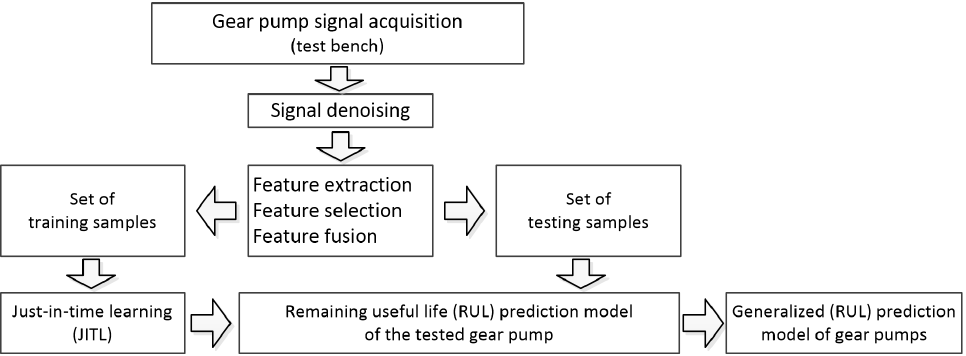
Figure 7. Flow diagram of a hydraulic gear pump remaining useful life prediction by